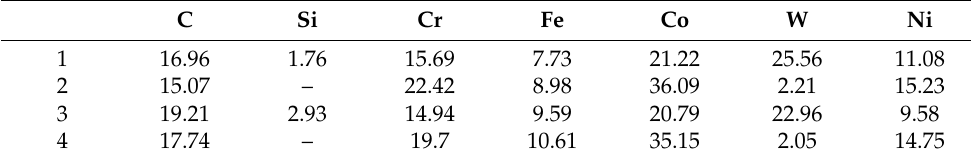
Figure 2. Surface SEM images of different coatings: ( a ) Fe-5 and ( b ) Fe-20. Table 3. Chemical composition (at %) of the surface of the spray welding